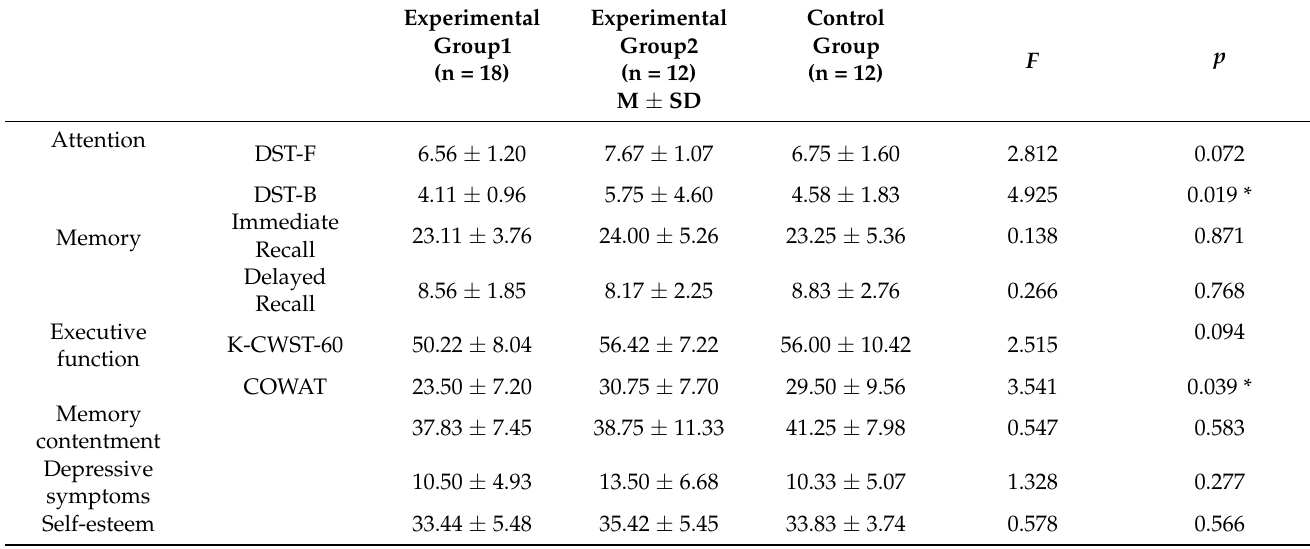
Table 2. Cognitive function, depressive symptoms, and self-esteem at baseline (N = 42).